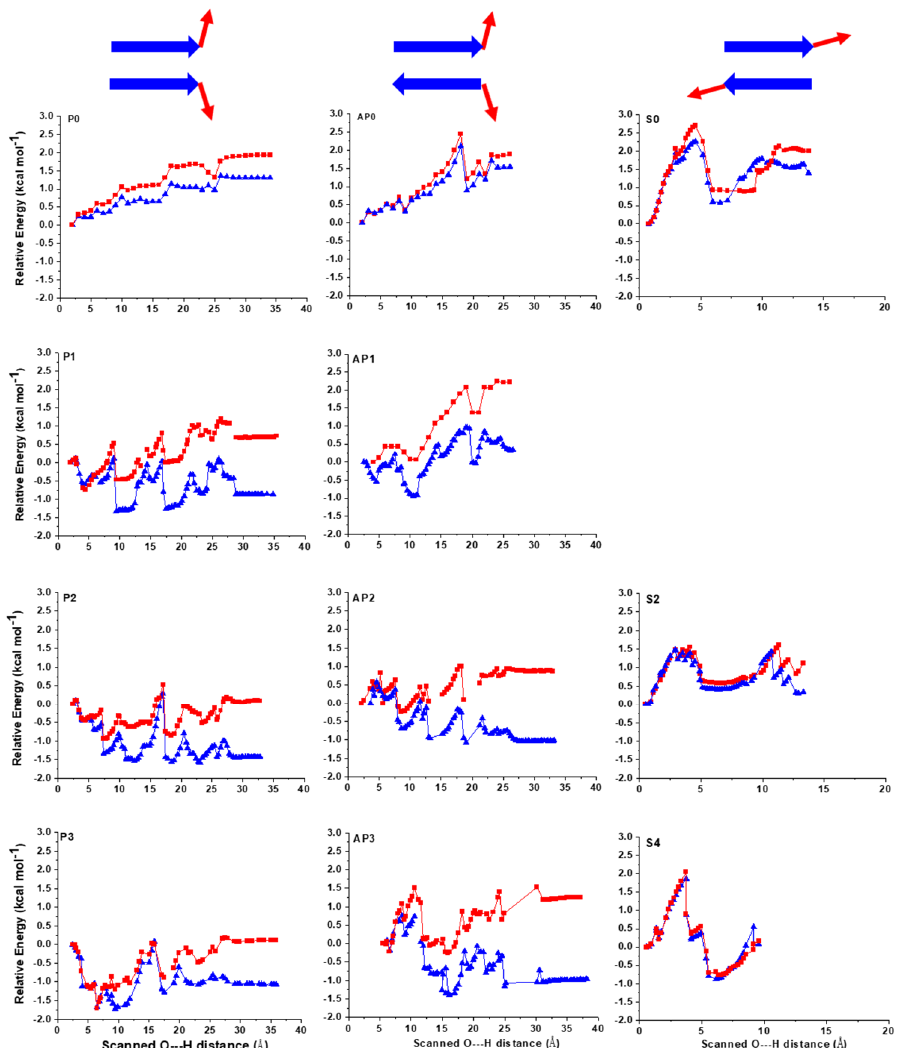
Figure 2. Lateral and sheared unfolding of parallel and antiparallel β -sheet models. TOP: models with 0 water molecules for lateral parallel (P0), lateral antiparallel (AP0) and sheared unfold (S0). MIDDLE: models with 1 or 2 water molecules for lateral parallel (P1;P2), lateral antiparallel (AP1;AP2) and sheared unfold (S2). BOTTOM: Models with 3–4 water molecules for lateral parallel (P3), lateral antiparallel (AP3) and sheared unfold (S4). Relative energies are in kcal · mol − 1 and normalized to the number of amino acids present in the models. LP environment is shown as red; W as blue line.